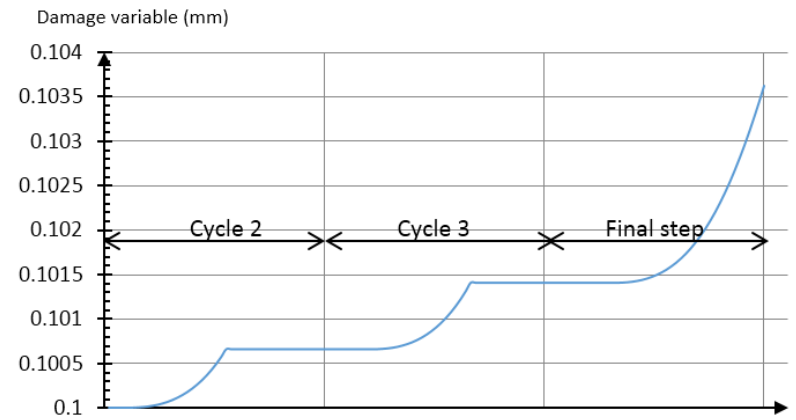
Figure 21. Evolution of the damage variable l [mm] over cycles “2”, “3”, and the final step.